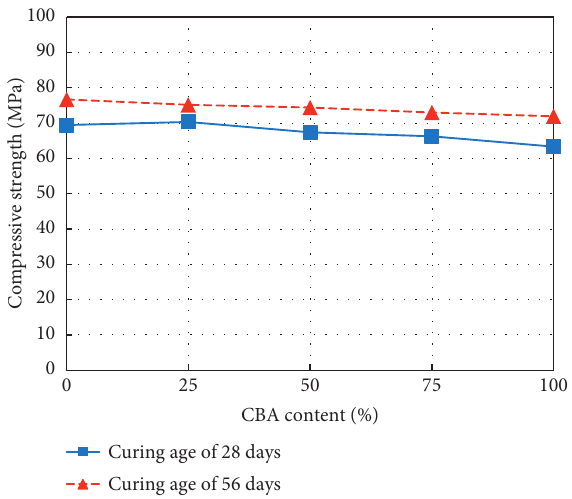
Figure 6: Compressive strength test results.